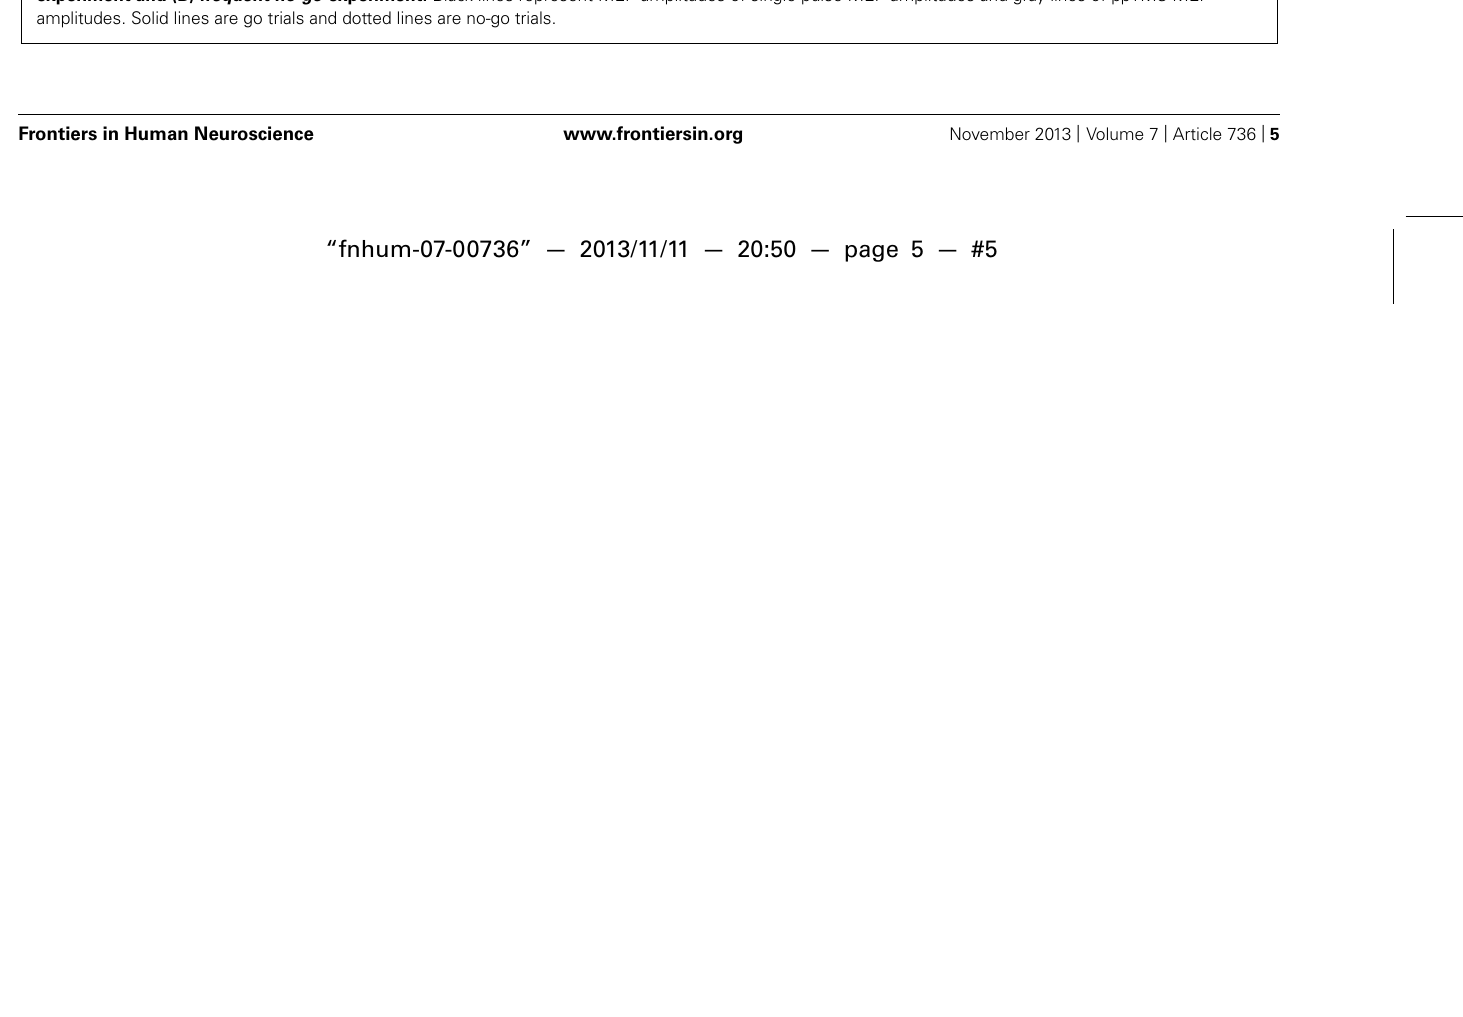
FIGURE 2 | Z -scored MEP amplitudes of single-pulse (sp) and paired-pulse (pp) MEPs for go and no-go trials at three SOA for (A) frequent go experiment and (B) frequent no-go experiment. Black lines represent MEP amplitudes of single-pulse MEP amplitudes and gray lines of ppTMS MEP amplitudes. Solid lines are go trials and dotted lines are no-go